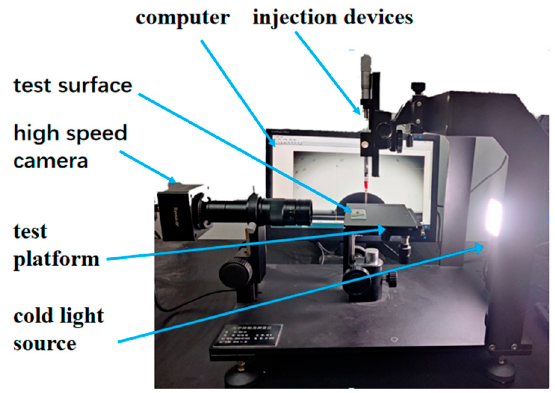
Figure 6. Schematic of the experimental apparatus.